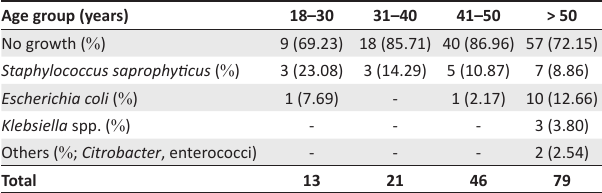
TABLE 1: Distribution of isolates by participant age ( n =